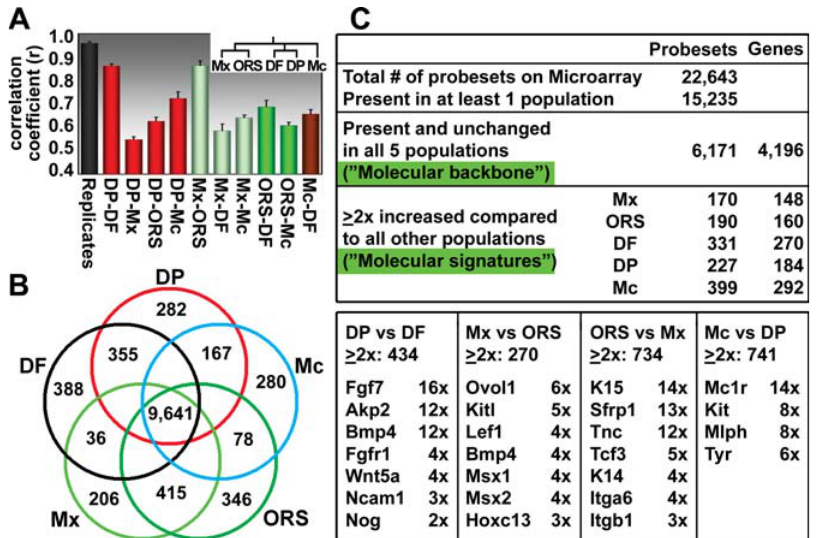
Figure 3. Gene Expression Patterns of the Five Hair Follicle/Skin Populations (A) Overall correlation of gene expression profiles between different cell types. A high correlation coefficient was observed between the DP-DF and Mx- ORS populations, consistent with their mesenchymal versus epithelial characters. Intriguingly, the least similar populations were the Mx and DP, which are strongly engaged in reciprocal exchange of signaling necessary for the maintenance of both compartments. Inset: Dendrogram outlining the correlation of gene expression between the populations. (B,C) The Venn diagram demonstrates the degree of similarity based on absolute present calls. Probe-sets were considered present only if they were called present in both replicates. Note that for each cell type, ; 200–400 probe-sets showed selective hybridization under these criteria, while ; 2/3 of all present probe-sets were represented in at least four or all five of the fractions and ; 4,000 genes ( ; 6,000 probe-sets) were expressed and unchanged in all five populations ( ‘‘ Molecular backbone ’’ ). When all five fractions were cross-compared, ; 150–300 genes ( ‘‘ Molecular signatures ’’ ) scored as being upregulated by (cid:2) 2 3 selectively in only cell type. The lists show array predictions for differential expression of mRNAs encoding some established, defining markers for each cell type, when compared against an adjacent or related cell population. The total number of mRNAs that show at least a 2 3 difference between the two cell populations is provided at the top, and the fold difference in specific mRNA levels is given next to each marker. DF, dermal fraction; DP, dermal papilla; Mc, melanocytes; Mx, matrix; ORS, outer root sheath. DOI: